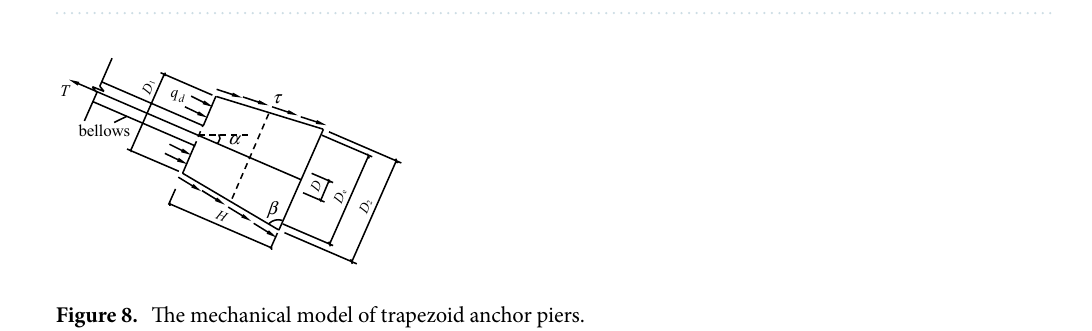
Figure 8. The mechanical model of trapezoid anchor piers.